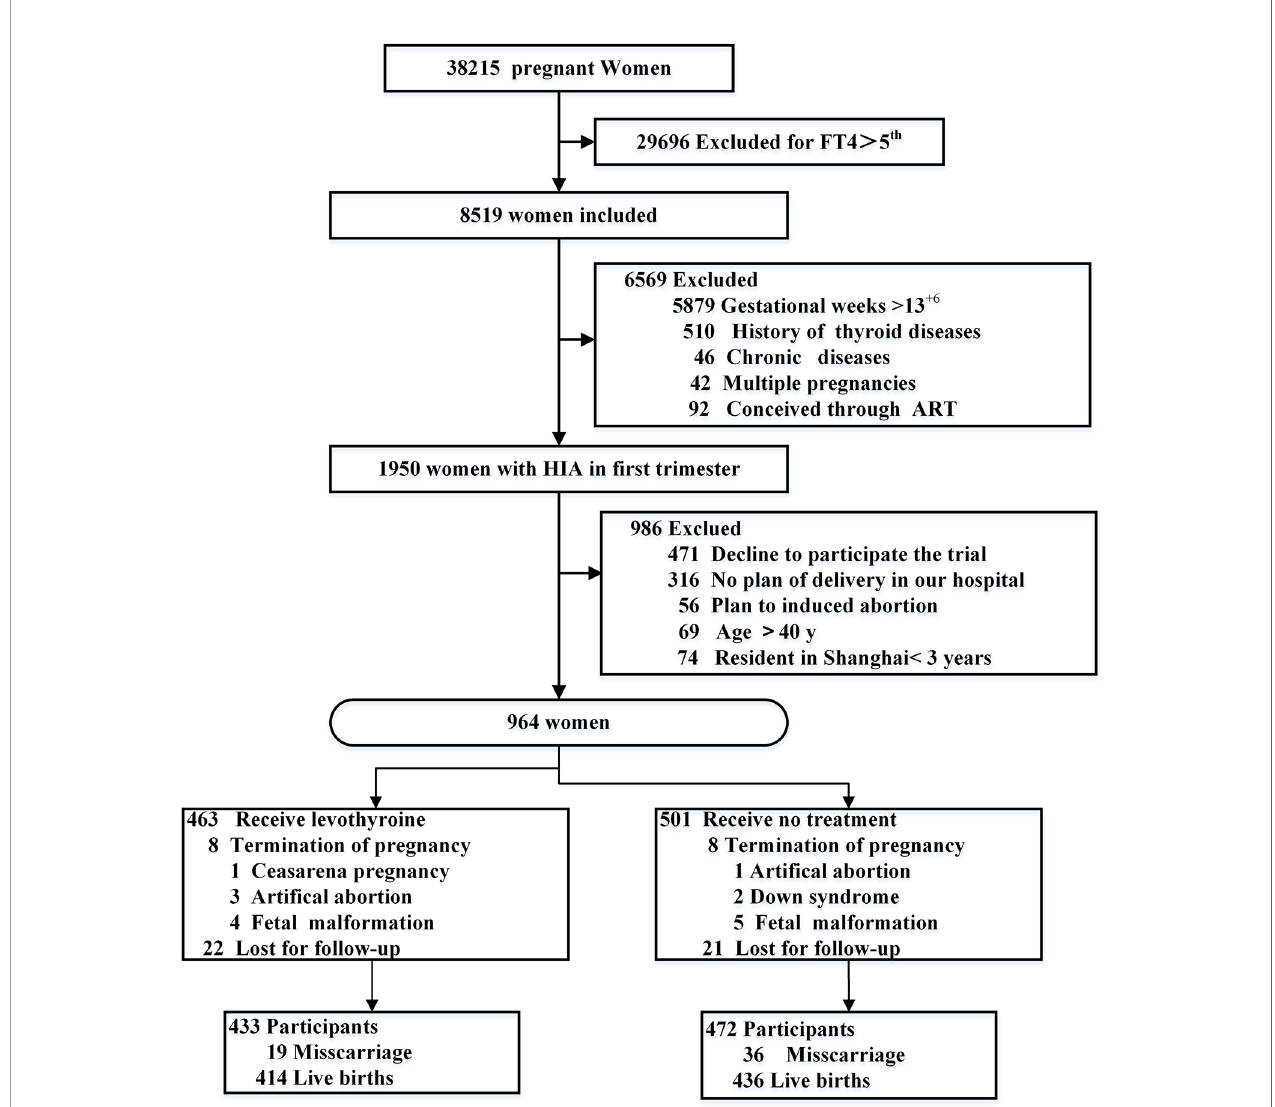
FIGURE 1 | Flowchart of the